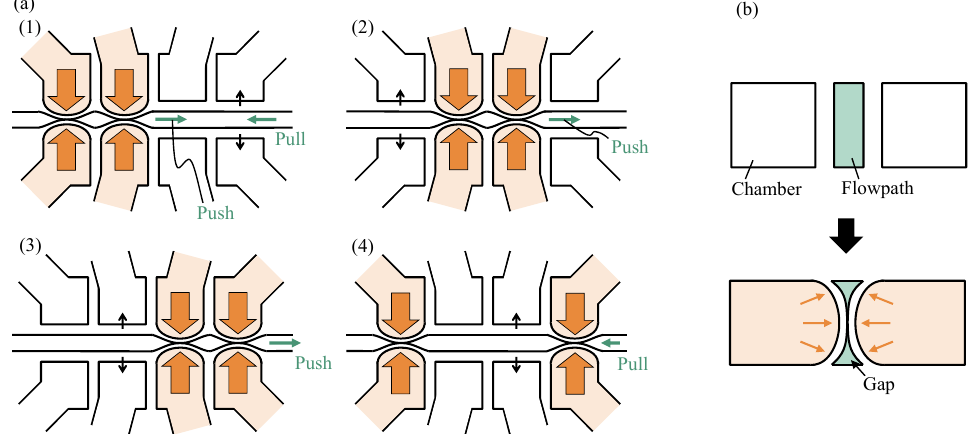
Figure 3. Relationship between peristaltic pump and pulsation: ( a ) pump pressurization sequence and pulsation; ( b ) cross-sectional view of the flow